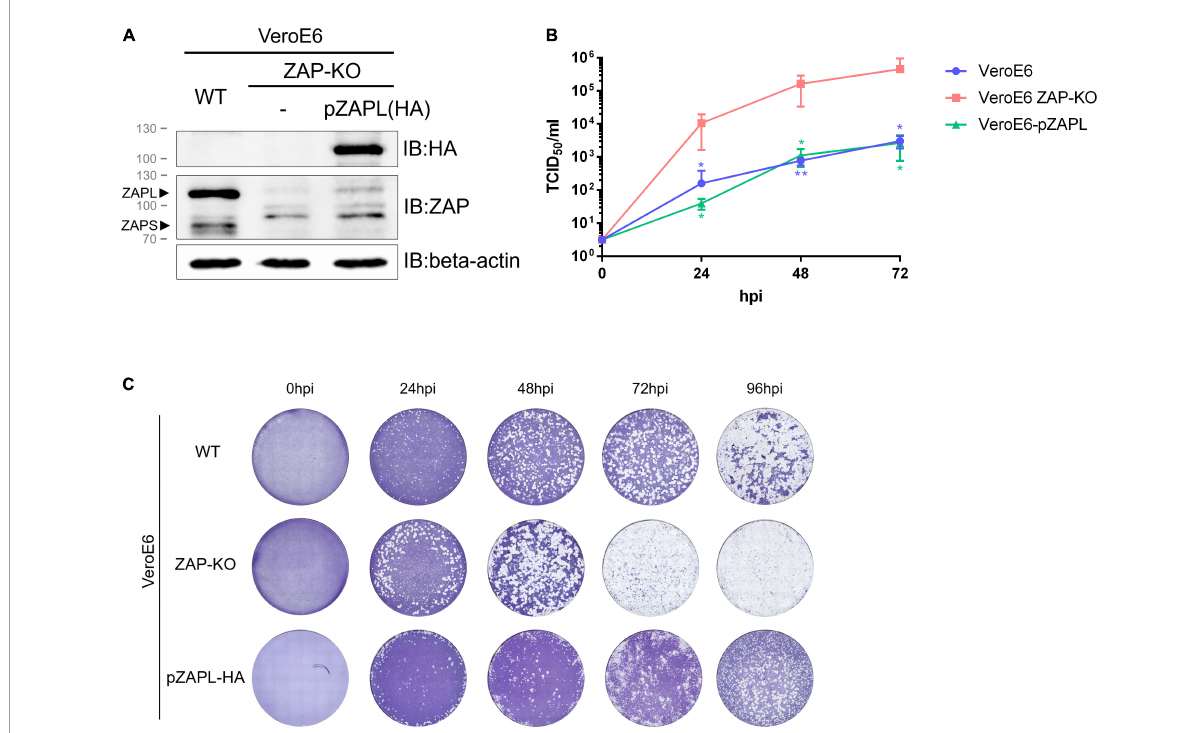
FIGURE1 Replication of porcine epidemic diarrhea virus (PEDV) is suppressed in VeroE6 cells by an endogenous or porcine cell-derived long isoform of zinc-finger antiviral protein (ZAP). (A) The VeroE6 ZAP-KO cell line was verified by western blot analysis. To generate a stable VeroE6 cell expressing only the HA-tagged long isoform of pZAP (VeroE6-pZAPL), VeroE6 ZAP-KO cells were transduced using the lentiviral transduction method. SDS-PAGE/western against the HA tag confirmed expression of HA-tagged pZAPL in the transduced cells. (B) VeroE6, VeroE6 ZAP-KO, or VeroE6-pZAPL cells were infected with PEDV (AVCT12 strain) at MOI = 0.0001. PEDV growth kinetics were monitored at the indicated time points using the TCID 50 assay. Values shown are averages ± SEM of three independent experiments (Student’s t -test, ** p < 0.05, ** p < 0.005). (C) Representative images showing the spread of virus at different time points post-infection were visualized with cytopathic effect (CPE) by crystal violet staining.